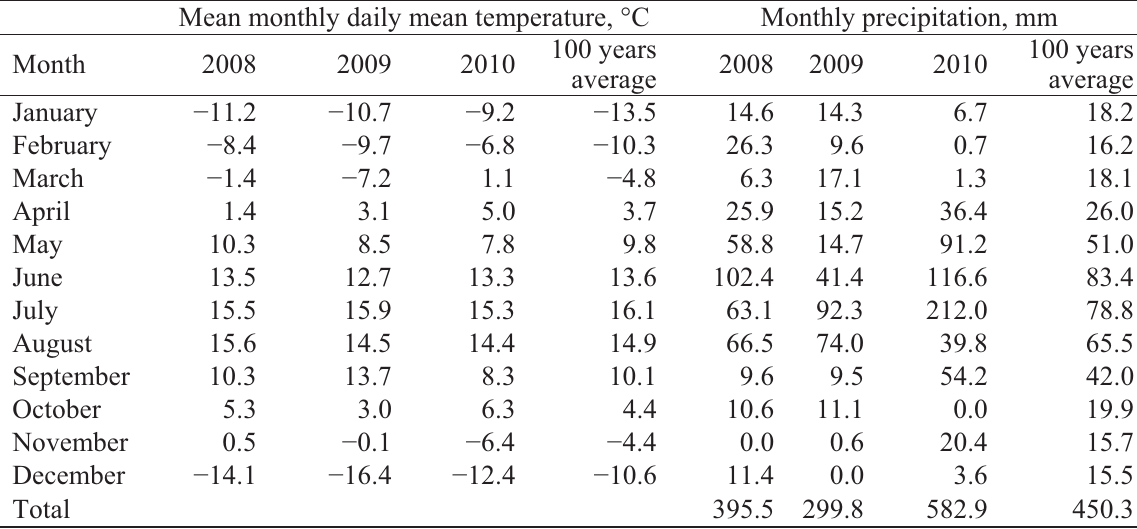
Table A3. Monthly mean temperature and total monthly precipitation at Lacombe, AB from 2008 to 2010.